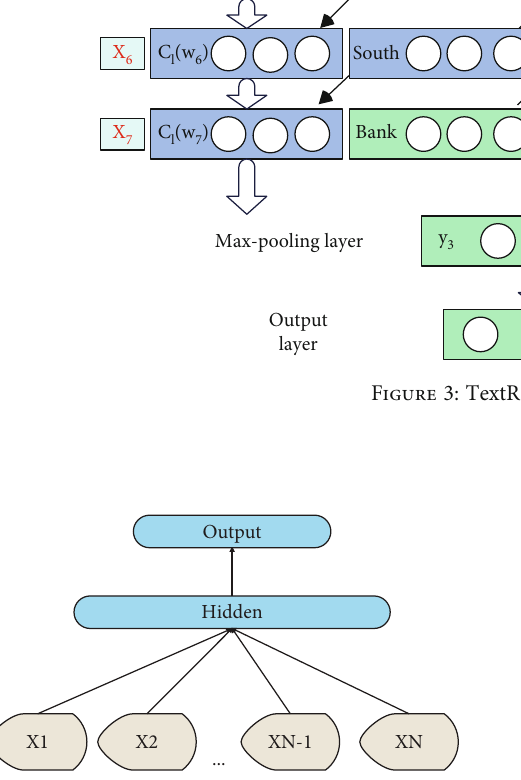
Figure 4: FastText model